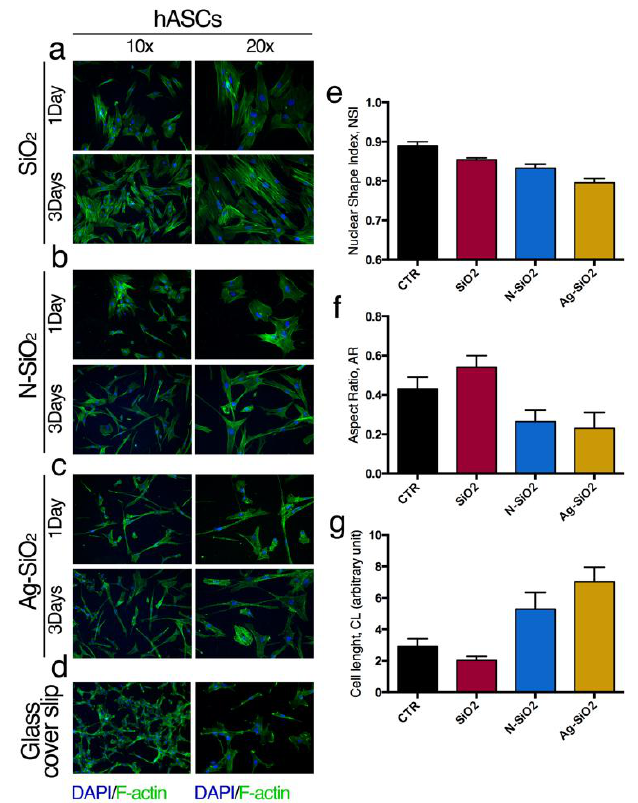
Figure 4. Interaction adult hASCs with nanoparticles: Immunofluorescence of hASCs seeded on ( a ) SiO 2 ; ( b ) N-SiO 2 ; ( c ) Ag-SiO 2 ; ( d ) Control culture. FITC-phalloidin: F-actin; DAPI: nuclei. ( e ) Nuclear shape Index; ( f ) aspect ratio; ( g ) cell length. See method section for details.